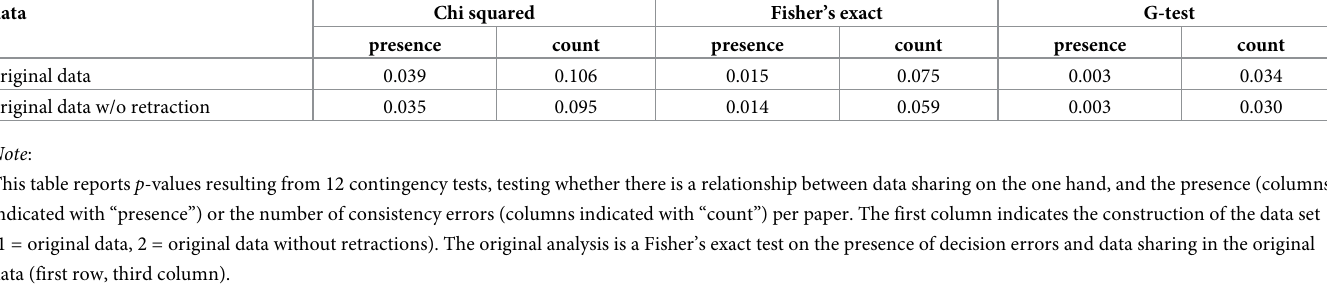
Table 4. Results of the multiverse analysis on association between decision errors and data sharing in original data set.